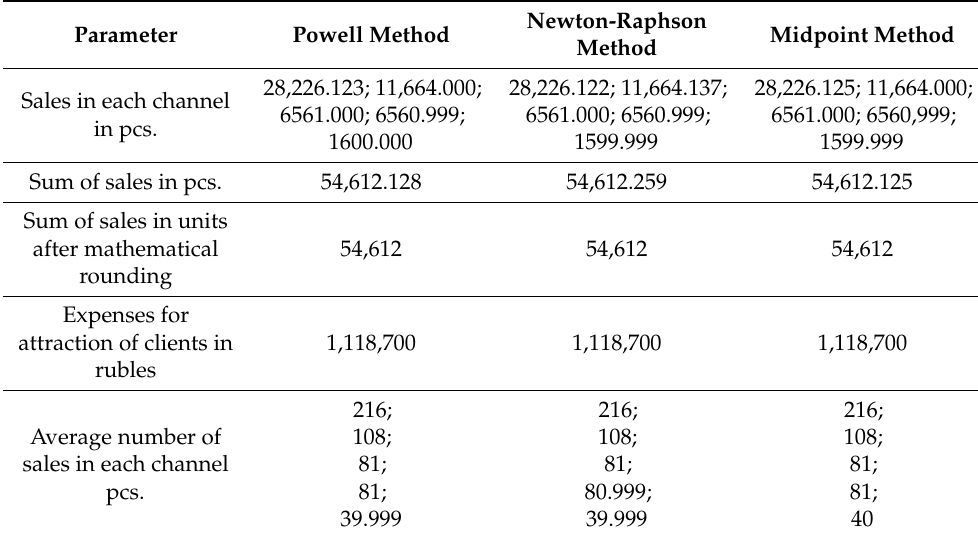
Table 13. Results of the search for the solution of the target function by methods from the group of polynomial approximation and methods based on derivatives for the year